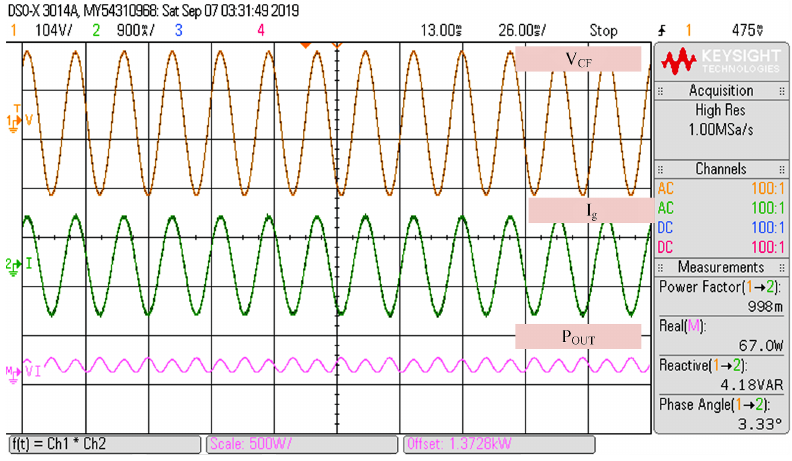
Figure 20. Power quality measurements during P max = 70 W.